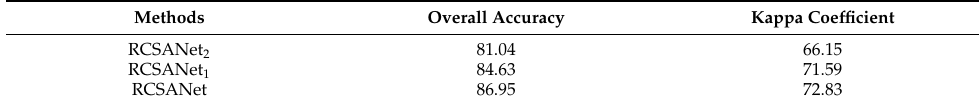
Table 6. Accuracy evaluation for RCSANet and its two varants RCSANet 1 and RCSANet 2 in Part 1 of the experiments (%). RCSANet 1 is a RCSANet variant ablating the first connection group and RCSANet 2 is the other variant ablating both connection groups.